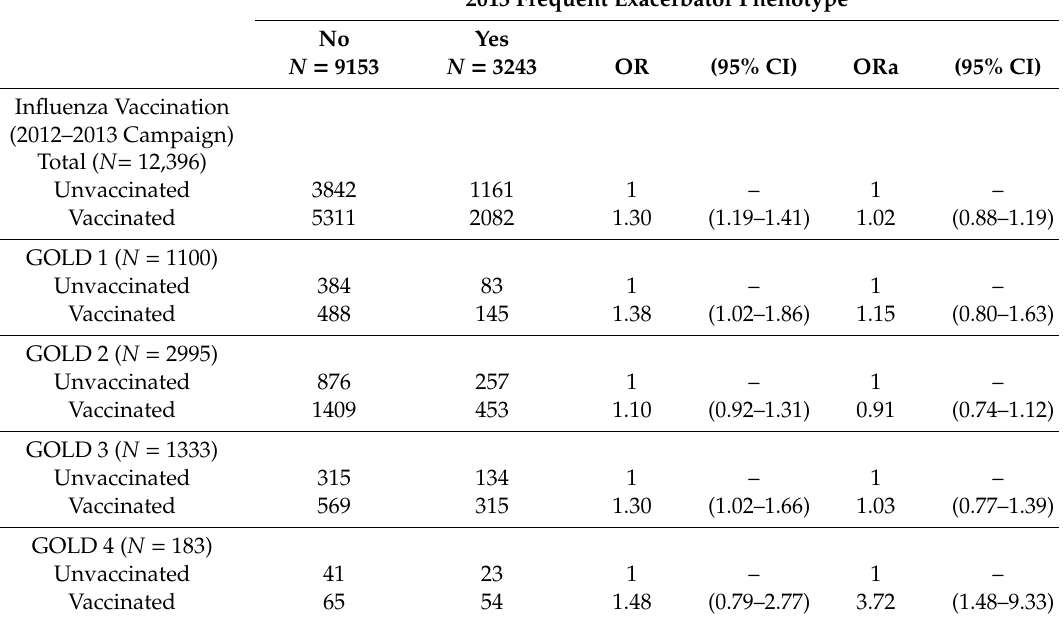
Table 5. Crude and adjusted associations between “History of Influenza Vaccination” and risk of being “Frequent exacerbator phenotype” the following year in all patients with a diagnosis of COPD by obstruction